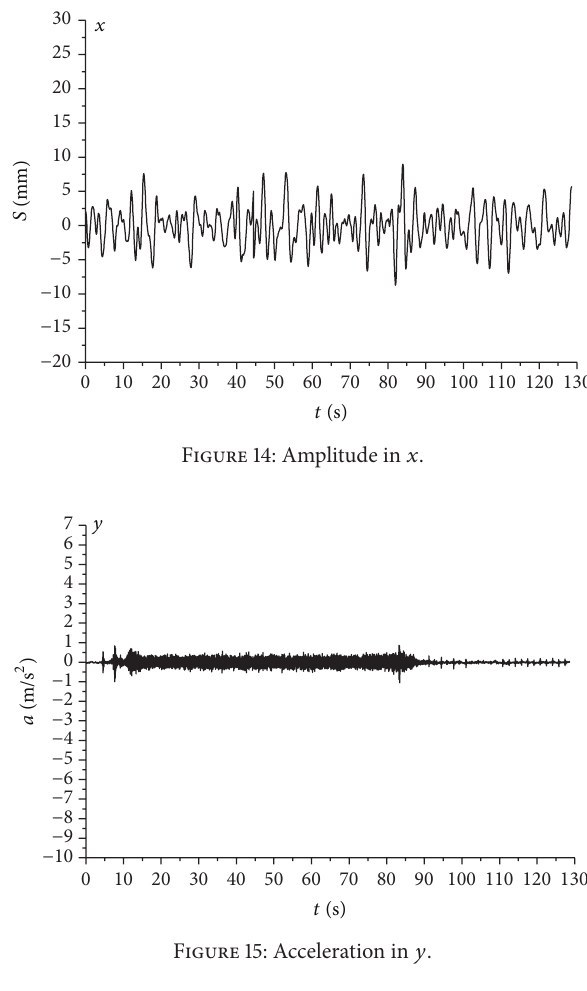
Figure 15: Acceleration in 𝑦